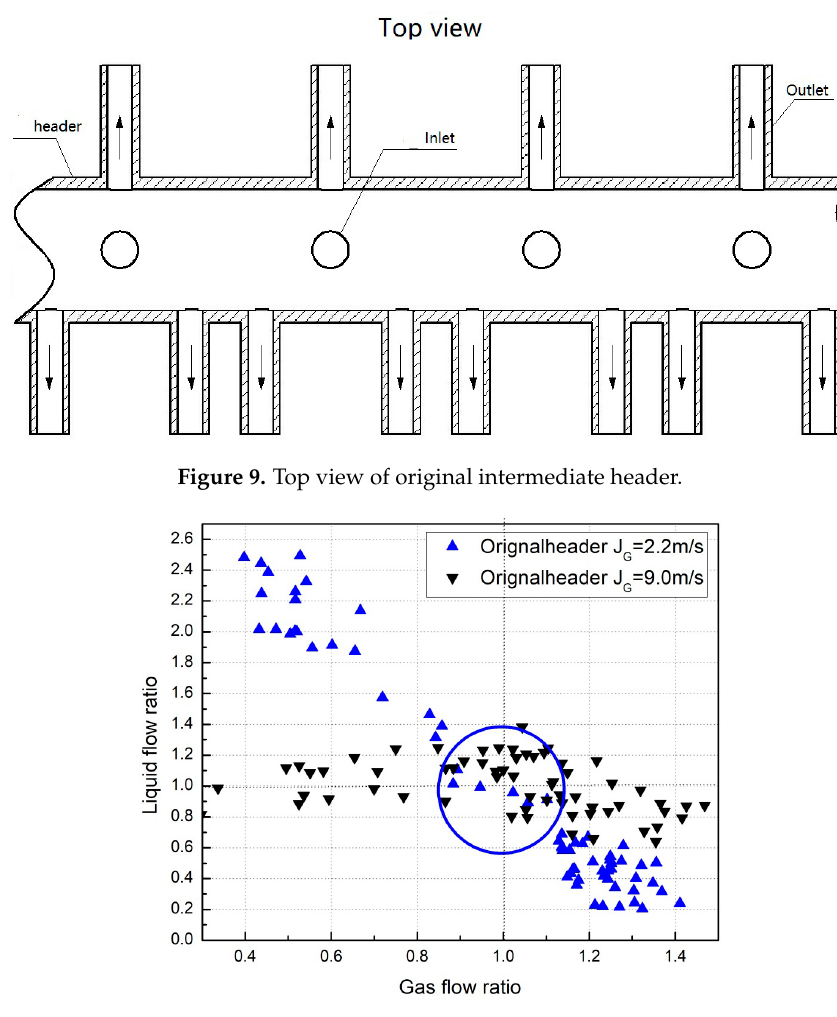
Figure 10. The two-phase flow ratio distribution in original intermediate header.